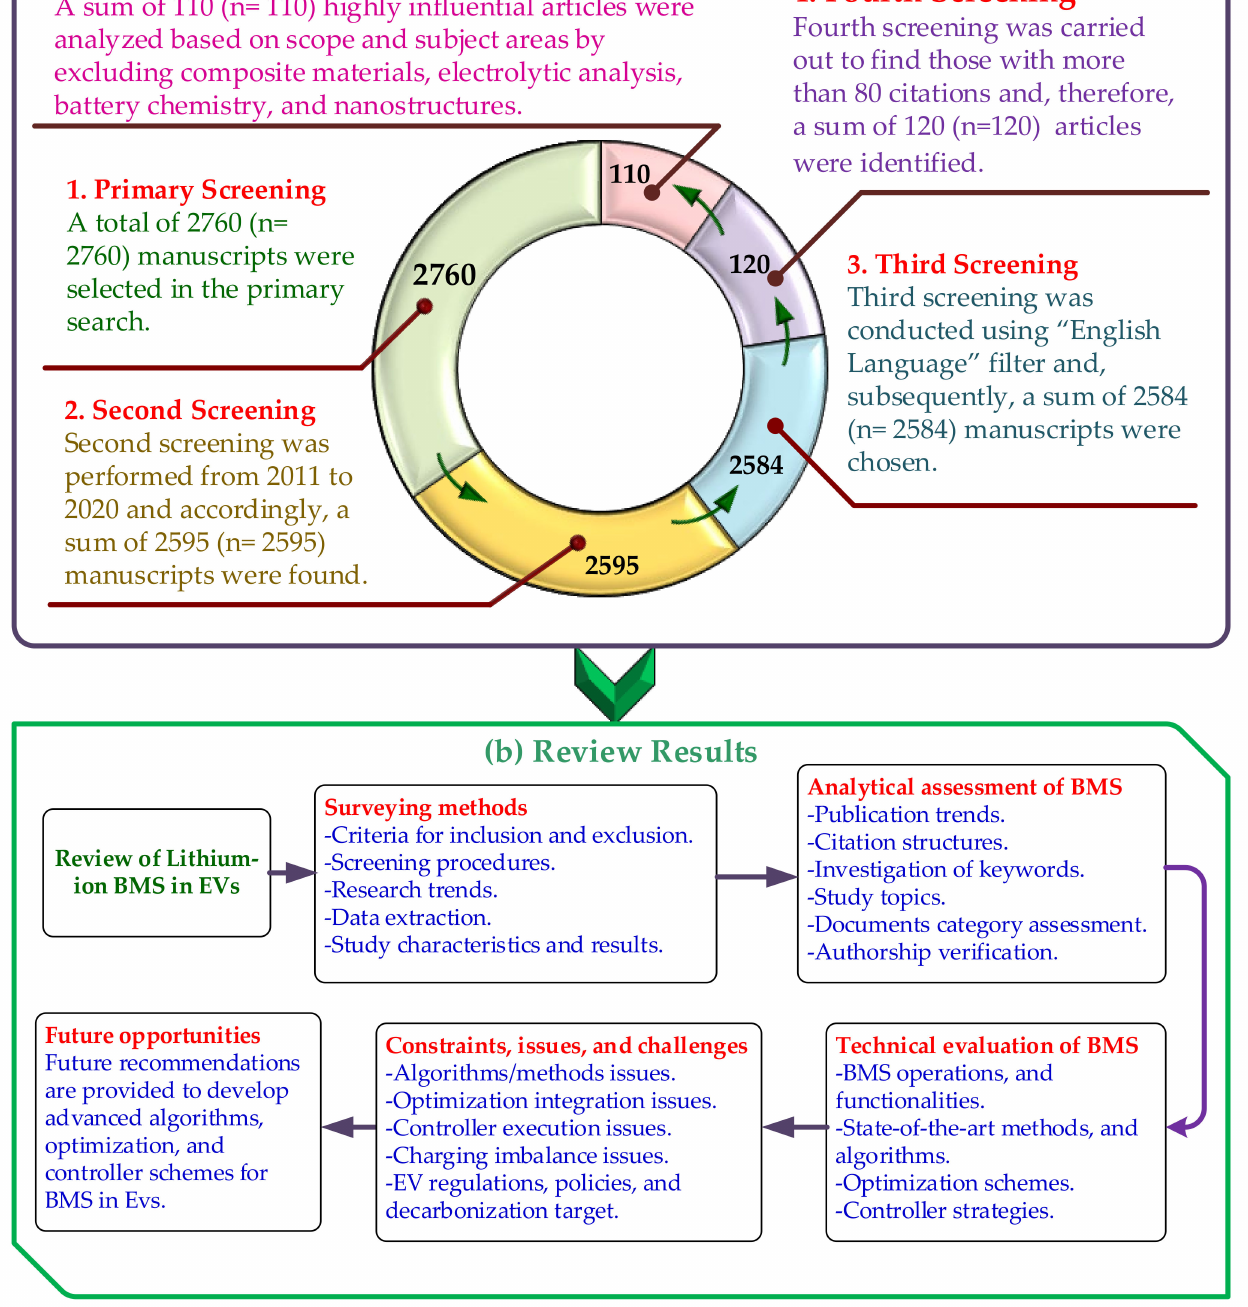
Figure 1. Methodology of extracting data and article selection from the Scopus